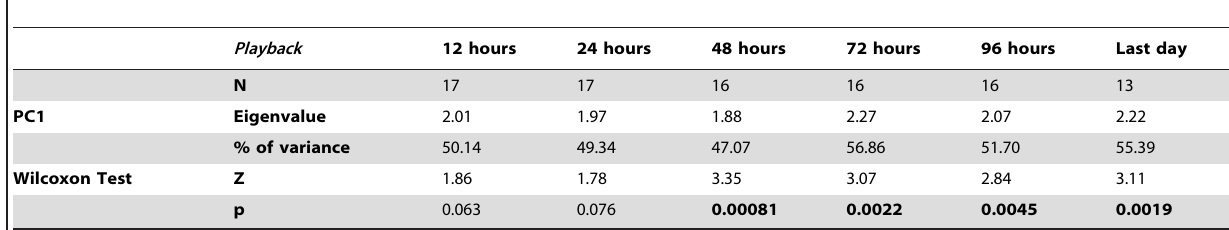
Table 1. Summary of